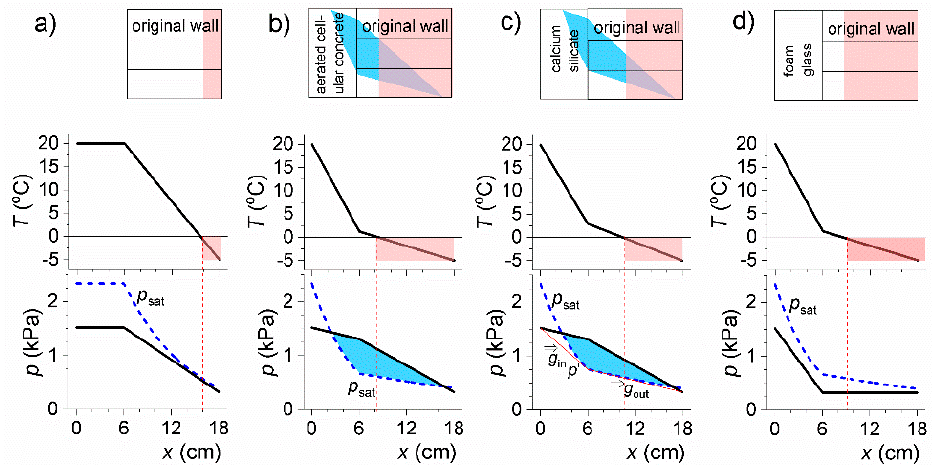
Figure 6. Temperature and water vapour pressure dependences in the original wall alone ( a ) and with three different interior insulations ( b – d ). Red background colour marks regions where the temperature is below 0 ◦ C, while blue background colour marks the region where water condensation occurs.